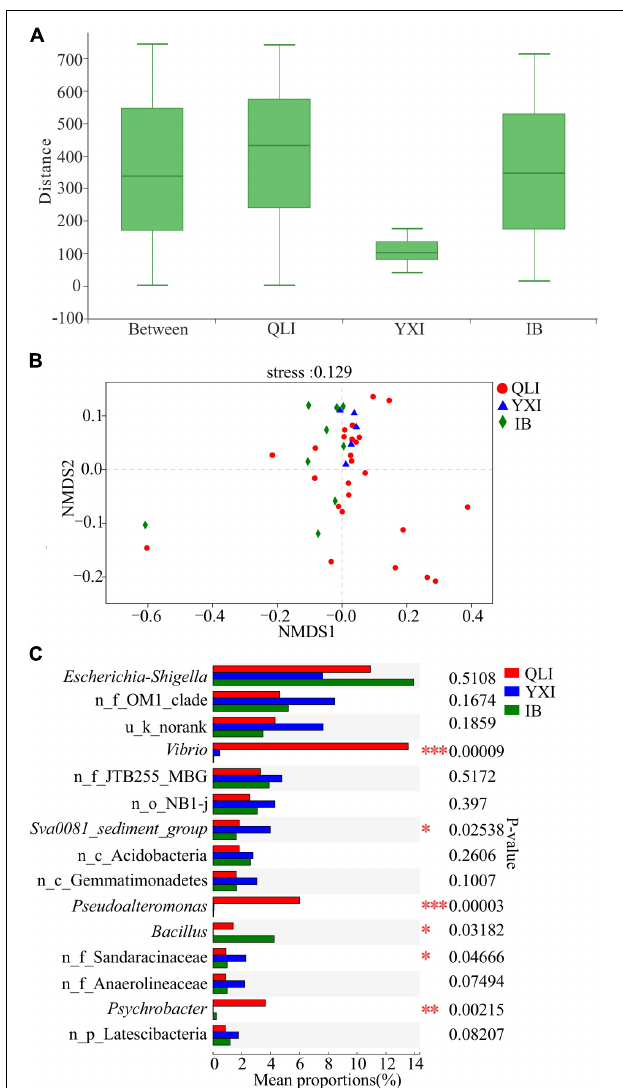
FIGURE 4 | Difference in microbial communities among three islands. QLI, YXI, and IB represent Qilian Island, Yongxing Island, and Iltis Bank, respectively. (A) Similarity within and between islands. ANOSIM analysis based on Bray-Curtis distance of bacterial community structure at the OTU level ( p = 0.775, r = –0.0785). (B) NMDS analysis based on Bray-Curtis distance of bacterial community structure at the OTU level among all 39 sediment samples. (C) Differences in bacterial abundance among three islands based on the Kruskal-Wallis test, and the p -value was checked using FDR. * p < 0.05; ** p < 0.01; *** p < 0.001. n_ and u_ indicate no rank and unclassified, respectively, MBG represents marine_benthic_group.